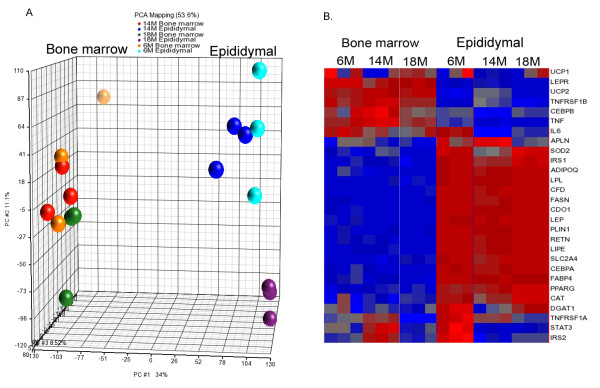
Bone marrow adipocytes are distinct from epididymal adipocytes. Bone marrow adipocytes and epididymal adipocytes were isolated from the same mice (age 6-month, 14-month and 18-month-old). Cells from several animals were pooled to yield sufficient sample to analyze three arrays for each age group and both adipocyte populations. A total of 18 arrays were included in the microarray analysis. A. Principal component analysis of array data before normalization showing clustering of bone marrow adipocytes as separate from epididymal adipocytes. B. Supervised hierarchical cluster analysis of 27 genes in adipocyte differentiation following normalization of all data sets.